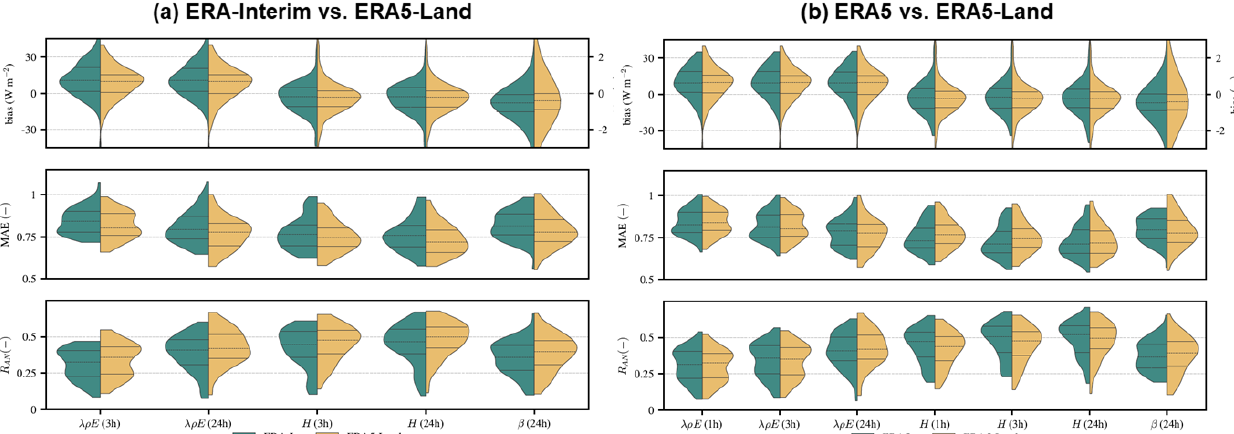
Figure 15. Violin plots showing the temporally and spatially averaged statistics of the surface latent heat flux ( λρE ), surface sensible heat flux ( H ), and Bowen ratio ( β ) from (a) ERA-Interim (green) and ERA5-Land (yellow) and (b) ERA5 (green) and ERA5-Land (yellow). Statistics are calculated with respect to in situ eddy-covariance measurements at both 3-hourly and daily (24h) temporal resolutions. Violin plots represent the distribution of the individual validation statistics with indication of the median and interquartile range, and are calculated using a kernel density estimation approach. Statistics include the bias, standardized MAE, and anomaly correlation coefficient ( R AN ). The scale used to show the bias distribution of β is that of the right y axis at the top row of each panel.